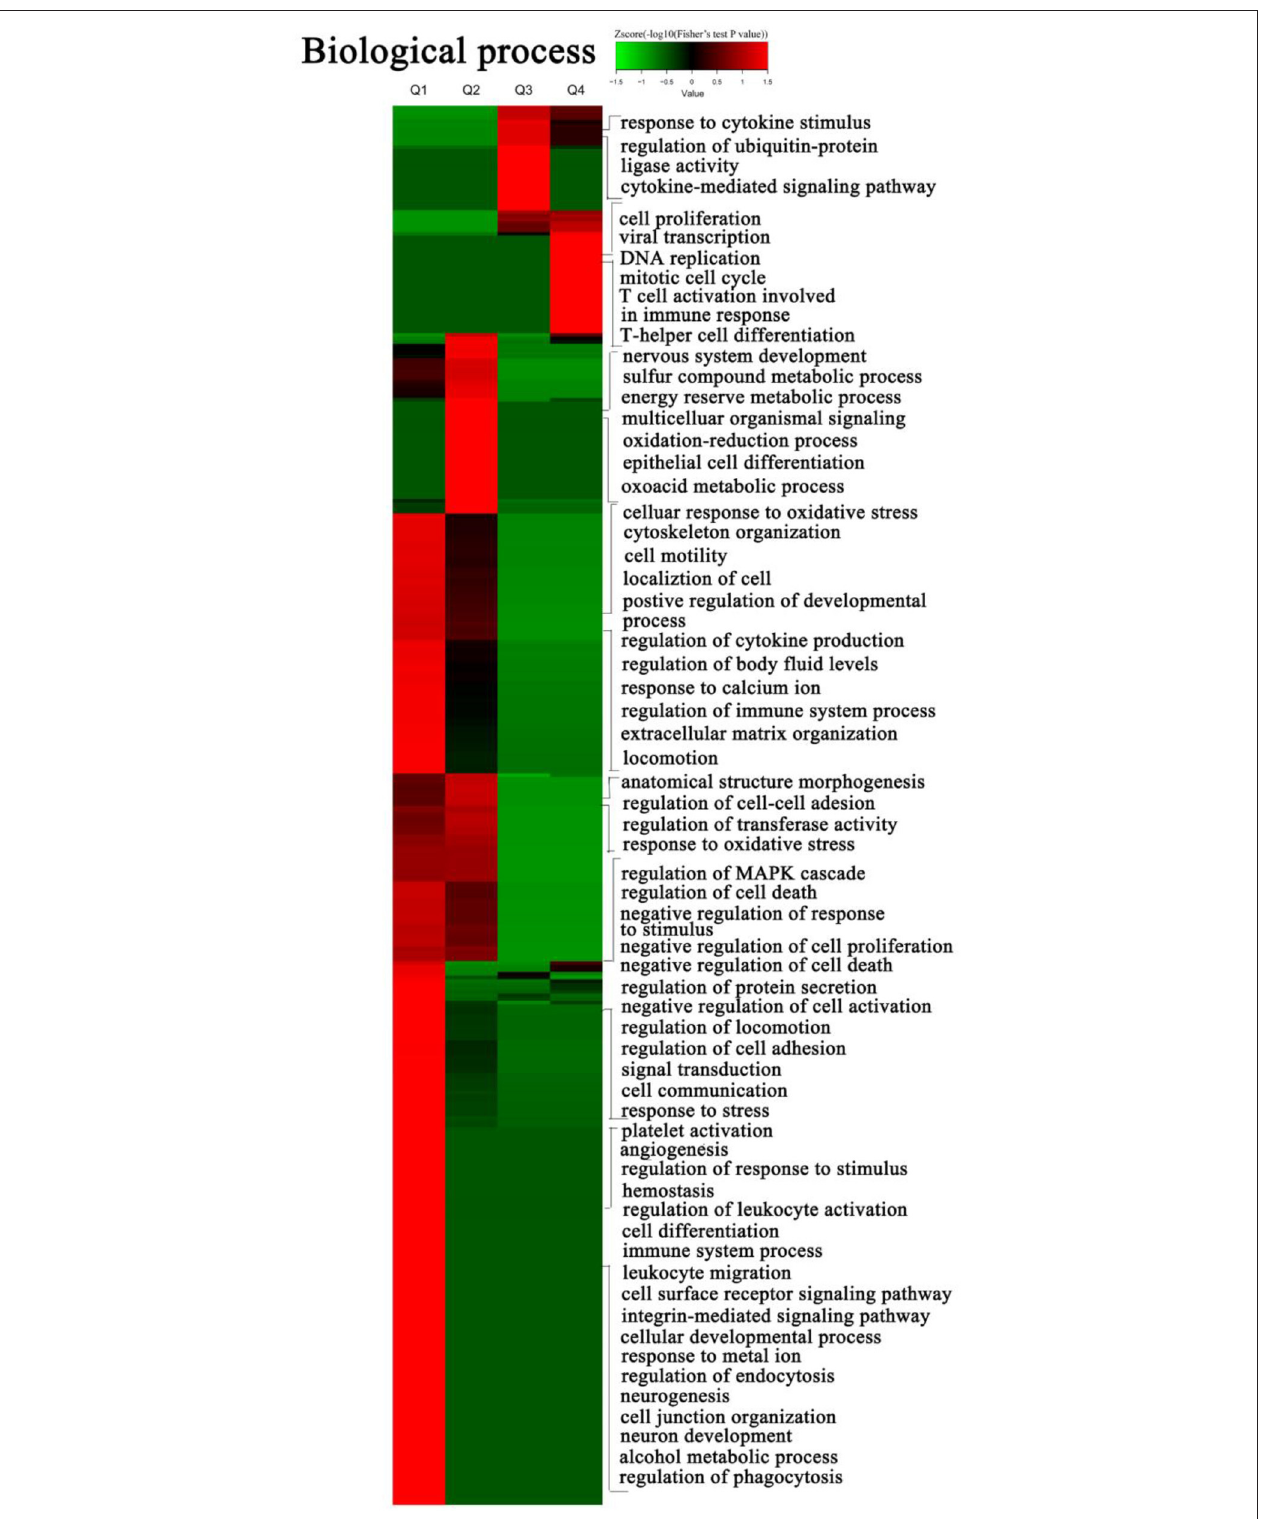
FIGURE 3 | Gene ontology (GO) enrichment-based cluster analysis. The differentially expressed proteins were classified by GO annotation based on the biological process. The quantified proteins in this study were divided into four quantiles according to the quantification ratio to generate four quantiles: Q1 (0 < Ratio iTfh/Naive < 0.5), Q2 (0.5 ≤ Ratio iTfh/Naive < 0.67), Q3 (1.5 < Ratio iTfh/Naive ≤ 2), and Q4 (Ratio iTfh/Naive > 2). An enrichment analysis was performed separately in each quantile, and the overrepresented annotations were clustered through one-way hierarchical clustering for comparative analysis.